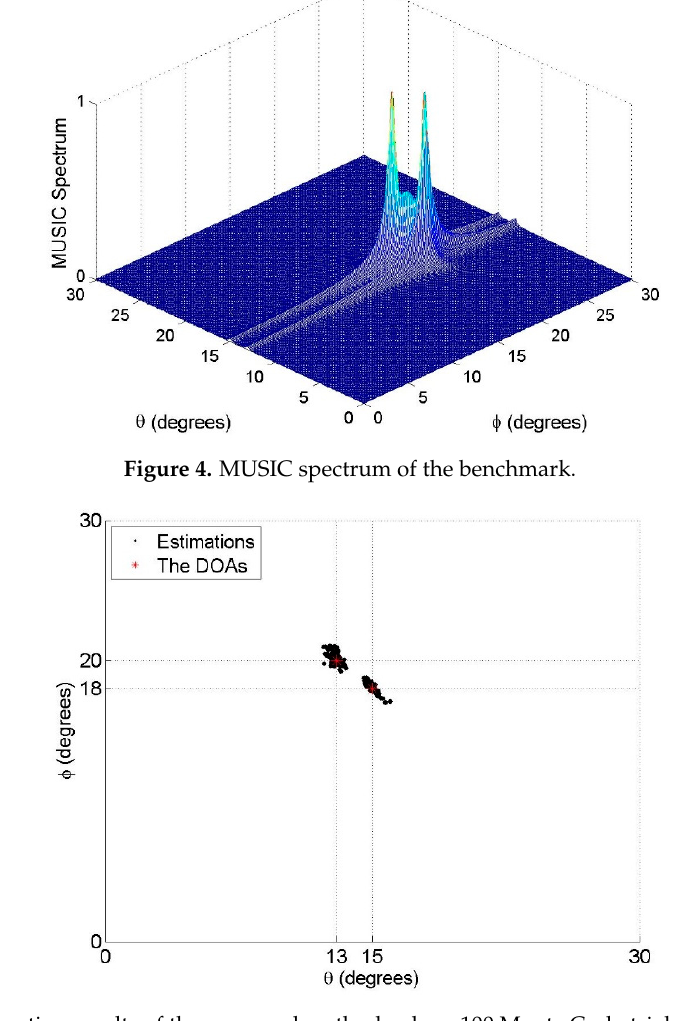
Figure 7. RMSE of the polarization parameter estimates versus SNR with T = 100 and T = 500. 6.4. Detection Performance In the following simulation, the source number detection performance of the models is investigated. Two sources with